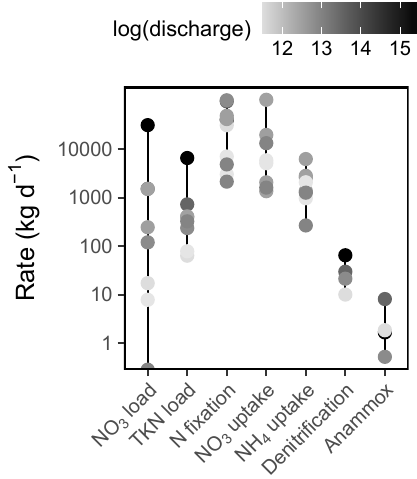
Figure 8. Rates of Sandusky River N loading and Sandusky Bay N cycling. Note the log scale on the y axis. The color of each point corresponds to the log-transformed Sandusky River discharge on each date (m 3 d − 1 ). Sandusky River N loads are presented only for the dates on which Sandusky Bay was sampled, but this is represen- tative of the range and distribution of loads throughout the